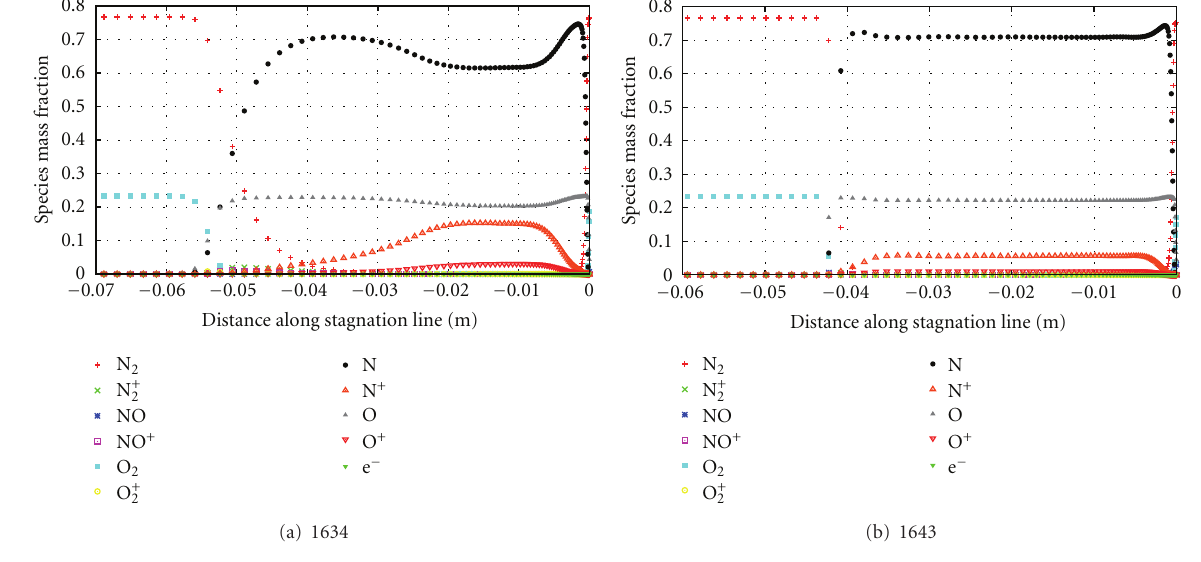
Figure 4: Species mass fractions on the stagnation